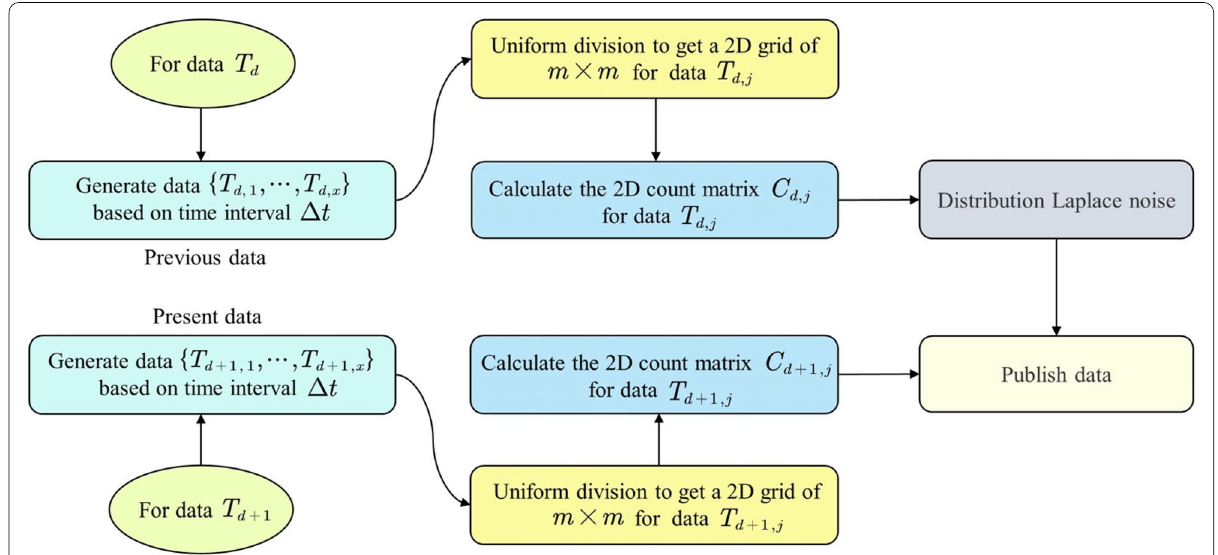
Fig. 2 Differential privacy data publishing process in the UG